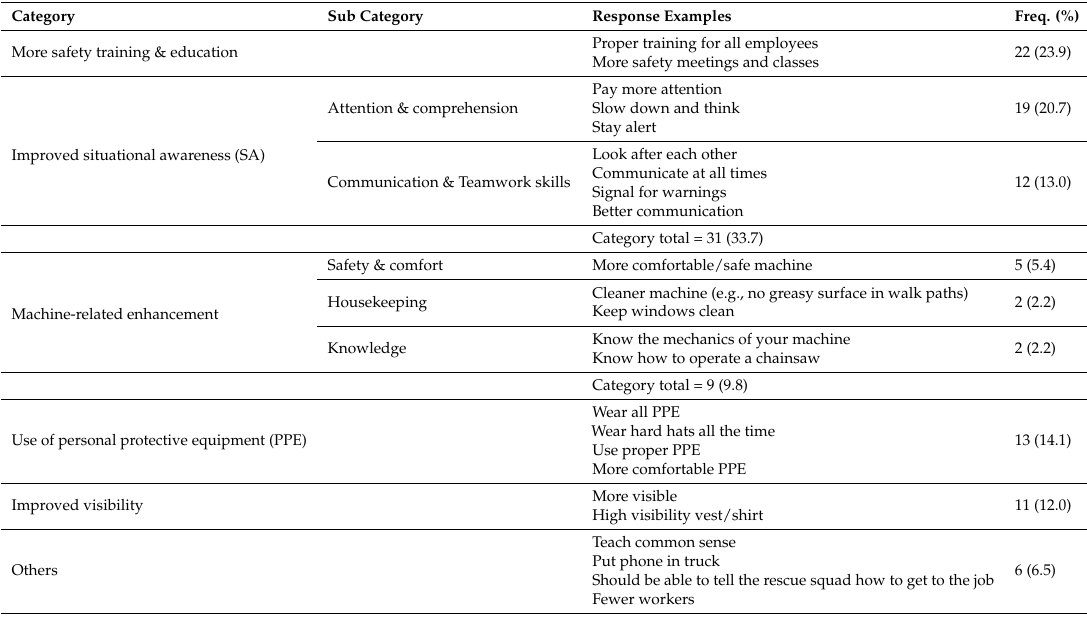
Table 5. Summary of suggestions ( total = 92 responses, from 81 individuals who responded to this open-end question) offered for safety improvements. Note that n in the table is the number of responses